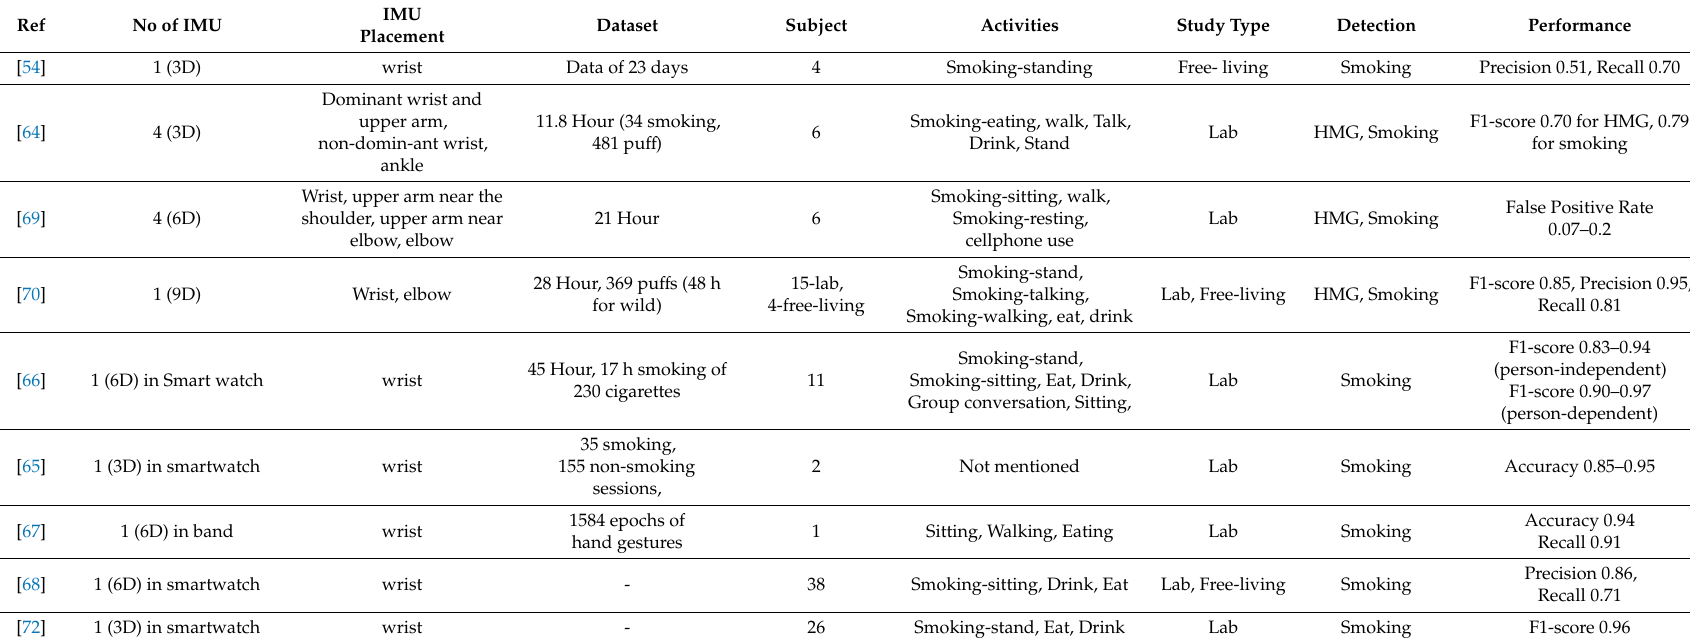
Table 8. Summary of detection algorithms employed on inertial